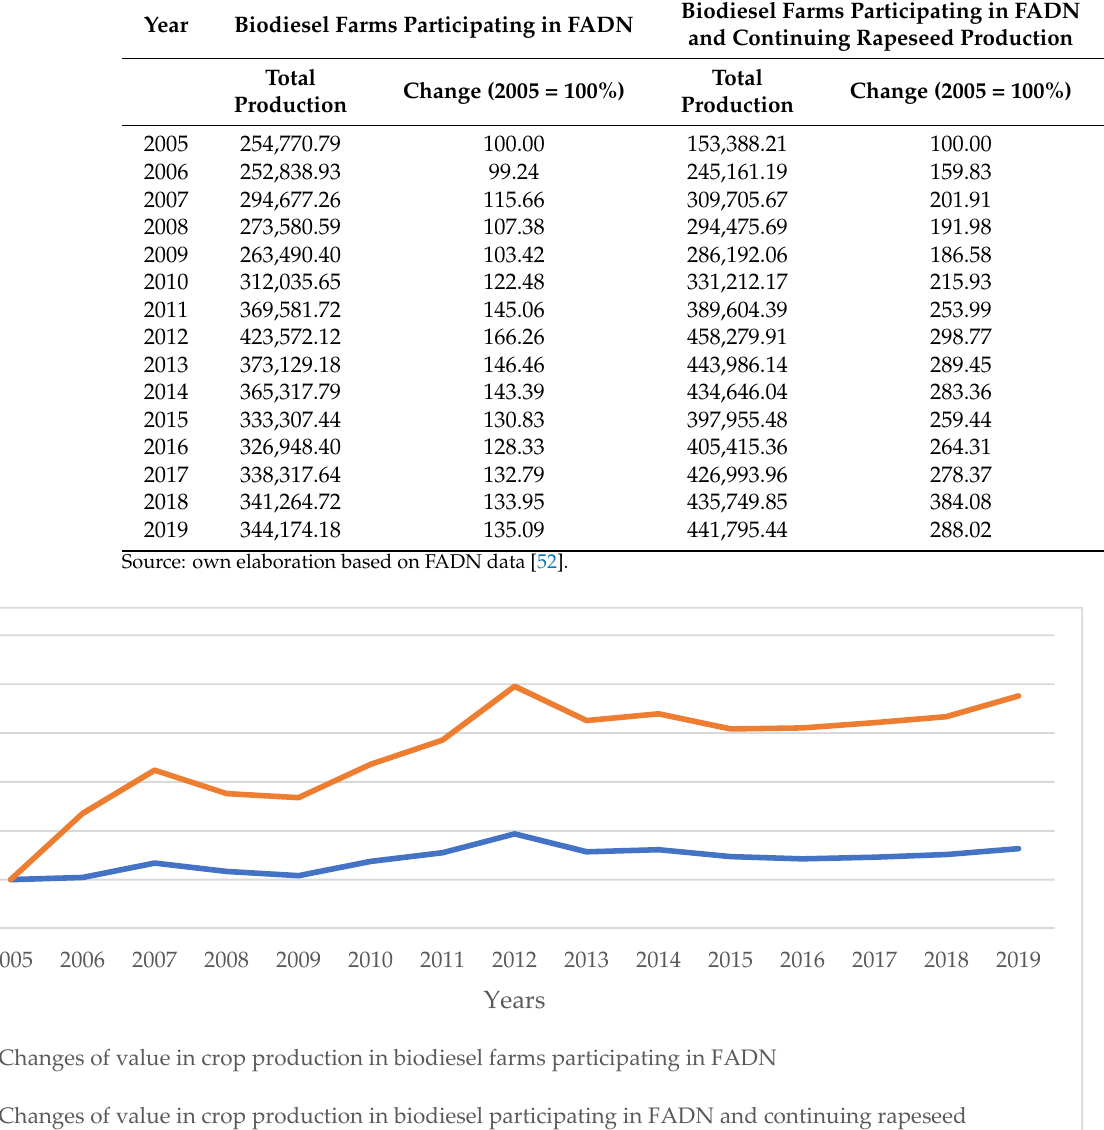
Table 5. Total production (PLN) in Polish biodiesel farms from 2005 to 2019.